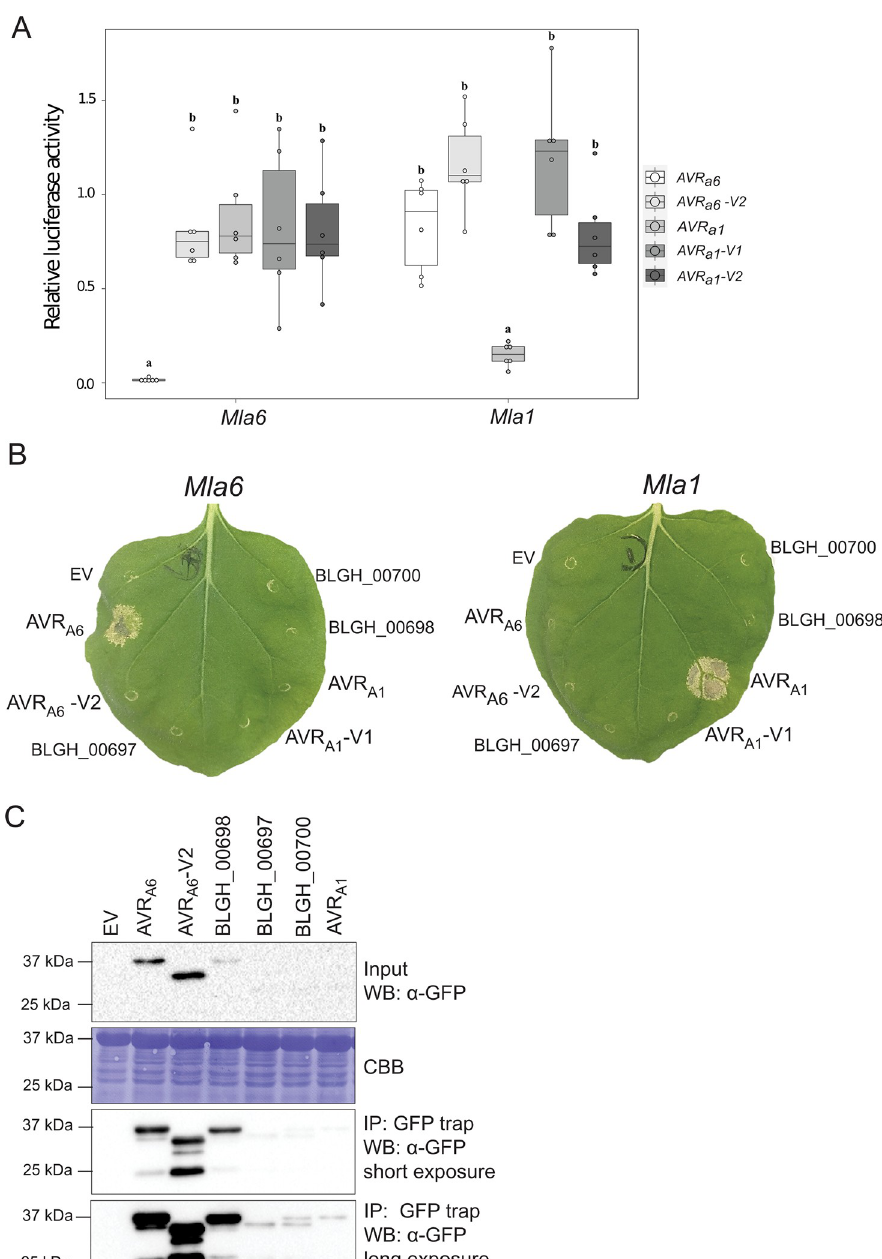
Fig 2. Mla6 and AVR a6 co-expression in barley protoplasts and N . benthamiana causes a specific cell death response. (A) Barley cv . Golden Promise protoplasts were transfected with pIPKb002 vectors containing cDNAs of Mla6 or Mla1 and either an empty vector (EV), AVR a6 , AVR a6 -V2 , AVR a1 , AVR a1- V1 , or AVR a1 -V2 variants lacking their respective signal peptides together with a pUBI : Luciferase construct. The LUC activity relative to the EV sample was measured as a proxy for cell death 16 h post transfection. Box plot diagrams show median of the relative LUC activity of six independent transfections, which are represented by dots, while the box shows the interquartile range. Significant differences between samples were analyzed using non-parametric Kruskal-Wallis (KW) analysis followed by a Dunn’s test. Calculated KW p -values are as follows: Mla6 : p = 0.007146; Mla1 : p = 0.0007392. Samples labeled with identical letters did not differ significantly ( p < 0.05) in the Dunn’s test for the corresponding Mla variant. (B) cDNAs of clade 1 AVR a6 family members BLGH_00698 , BLGH_00697 , BLGH_00700 , AVR a6 , and AVR a1 variants were expressed without their respective signal peptides and stop codons and with a C-terminal mYFP fusion under the control of a 35S promotor in N . benthamiana . The effectors were co-expressed with Mla1 and Mla6 cDNAs fused C- terminally with a 4xmyc tag under the control of a 35S promotor. Cell death was scored five days post infiltration